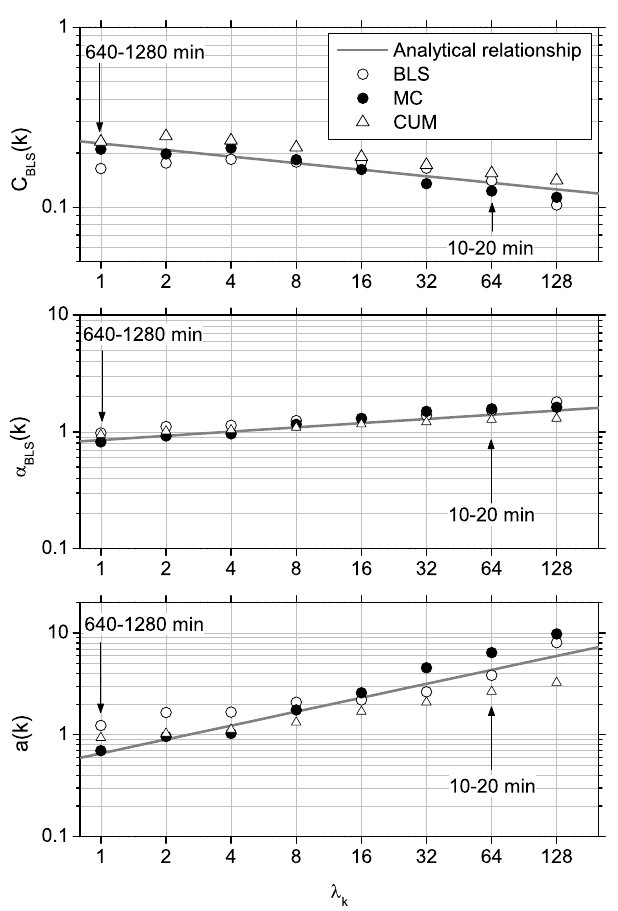
Fig. 5. Relationships between the models’ parameters and scale for the representative series used in Fig.